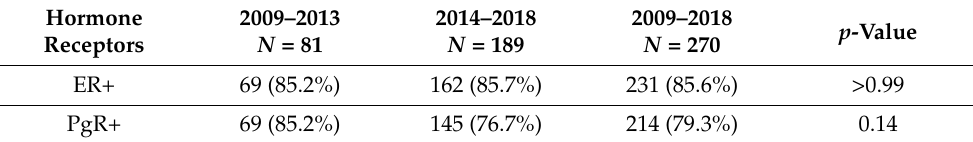
Table 6. Hormone receptors